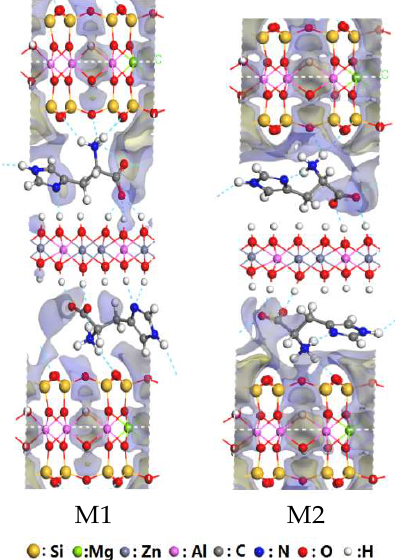
Figure 9. Simulations of electrostatic potentials of M1 and M2.